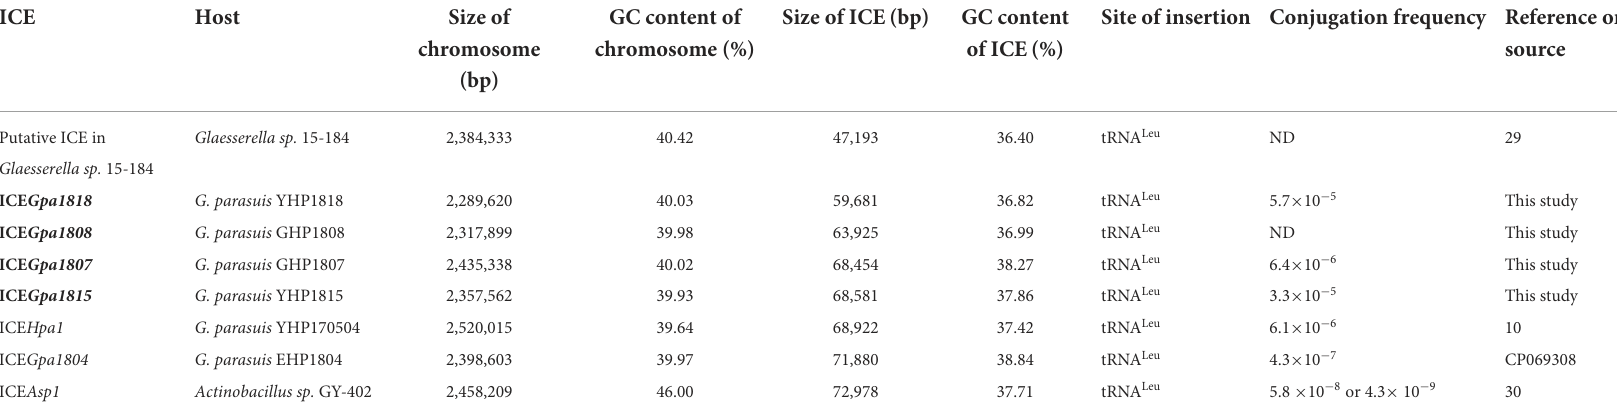
TABLE 2 General genetic features of ICEs from ICE Hpa1 family and their host strains.